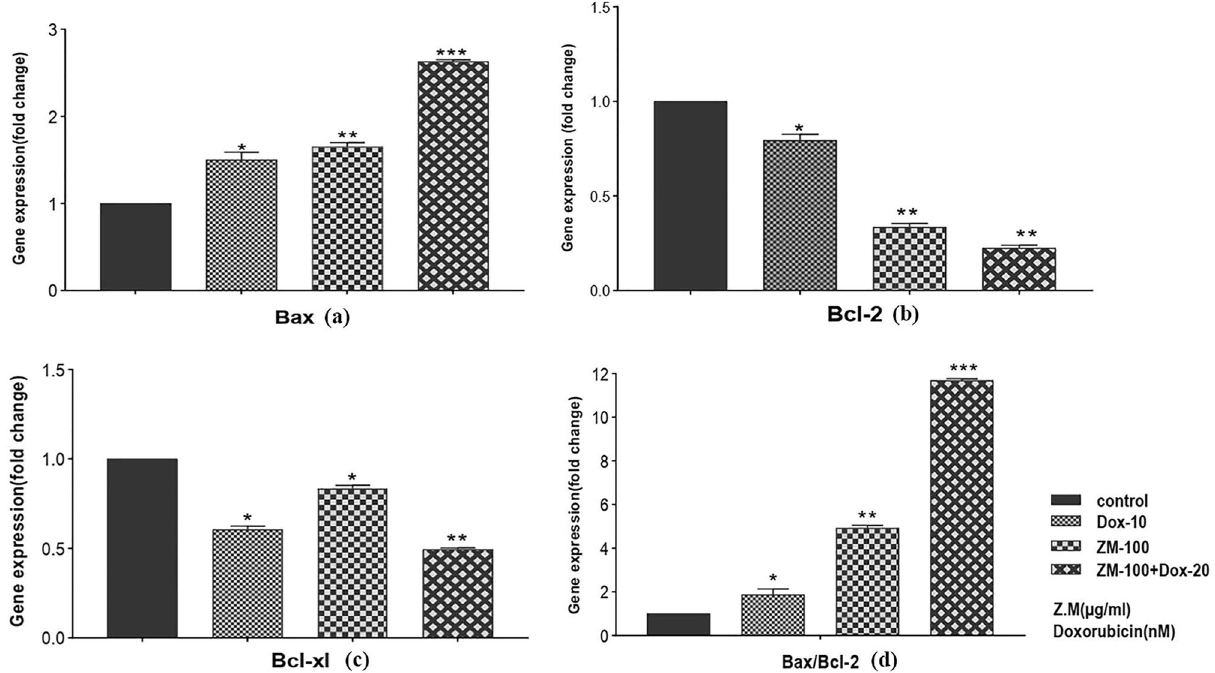
Figure 4. Fold change gene expression. Graph presents that ZME and DOX upregulate the Bax gene (pro- apoptotic) and down-regulates Bcl-2 gene (anti-apoptotic). A combination dose of ZME and DOX changes gene expression more than single doses on Nalm-6 cells after 48 h treatment. Bax and Bcl-2 ratio also was shown in this figure and demonstrated the significant effect of ZME and DOX in combination dose. In addition, Bcl-Xl from Bcl-2 family was upregulated by ZME and DOX treatment in Nalm-6 cells after 48 h (*P < 0.05, **P < 0.01, ***P < 0.001, relative to untreated